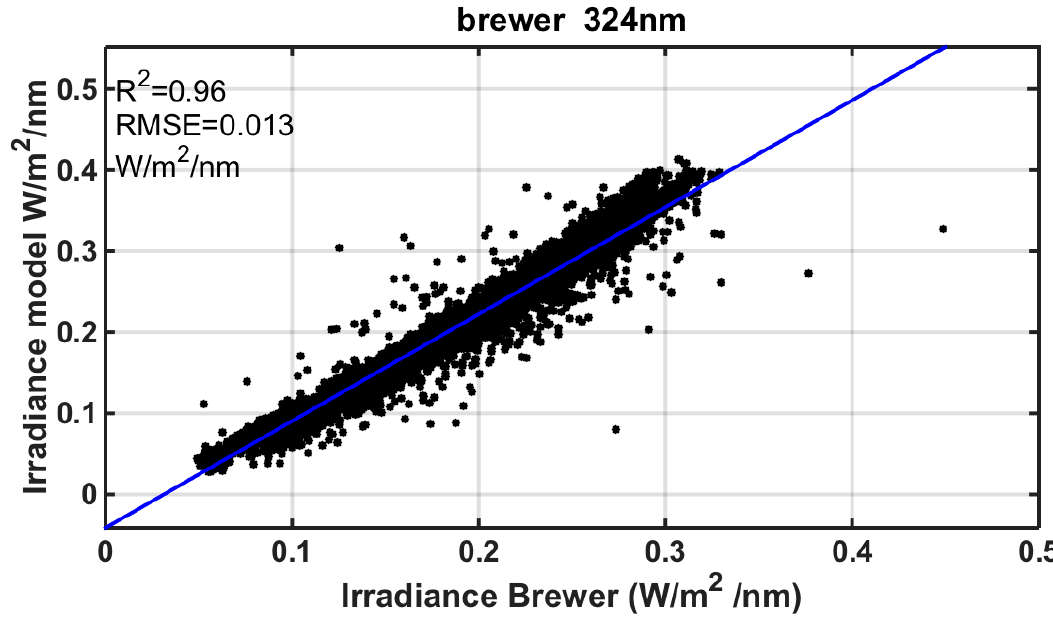
Figure 8. Cloudless synchronous retrievals of Global UV at 324 nm, measured from Brewer and calculated from model using UVMFR SSA and AOD at 332 nm inputs.